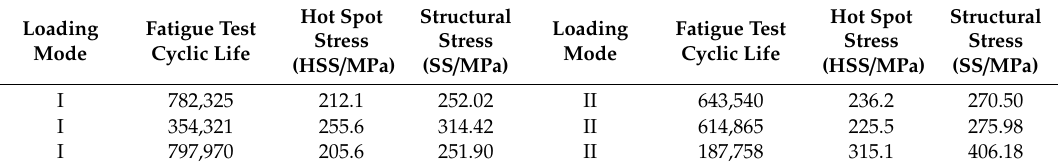
Figure 5. Master S-N curve based traction structural stress method. Table 1. Fatigue test results and numerical simulation results.